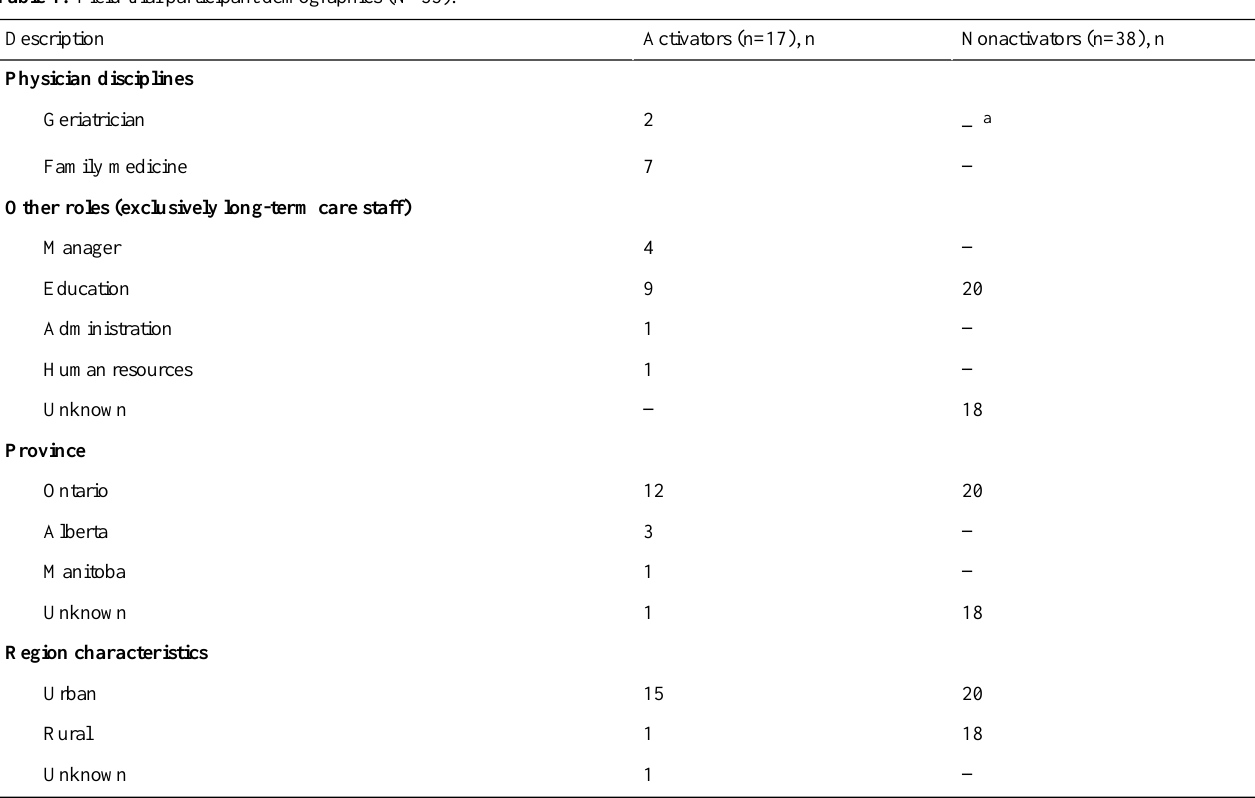
Table 1. Field trial participant demographics